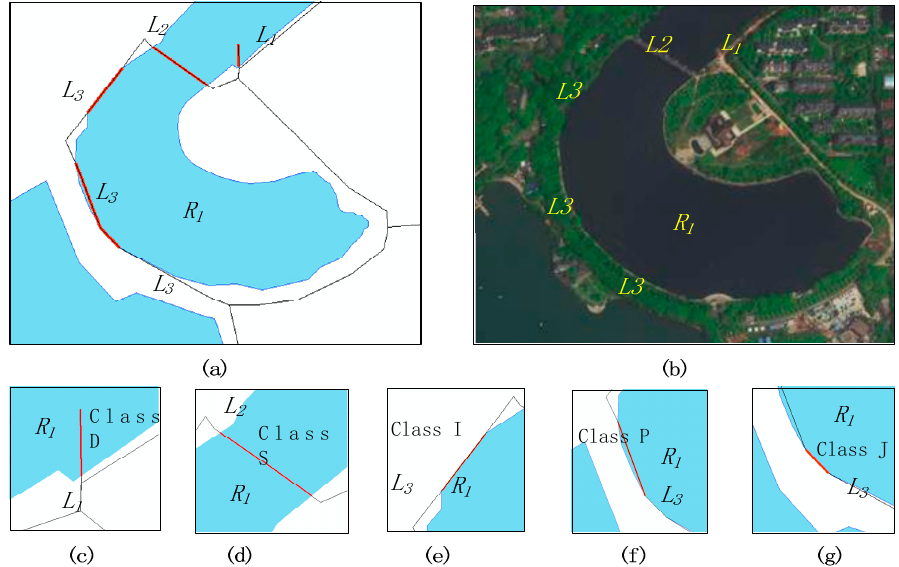
Figure 18. Examples of the intersection component types between traffic lines and water regions in the test data. ( a ) Intersection components between traffic lines and water regions; ( b ) Satellite images of the corresponding area; ( c ) The class (type) of intersection-line is D; ( d ) The class of intersection-line is S; ( e ) The class of intersection-line is I; ( f ) The class of intersection-line is P; ( g ) The class of intersection-line is J.